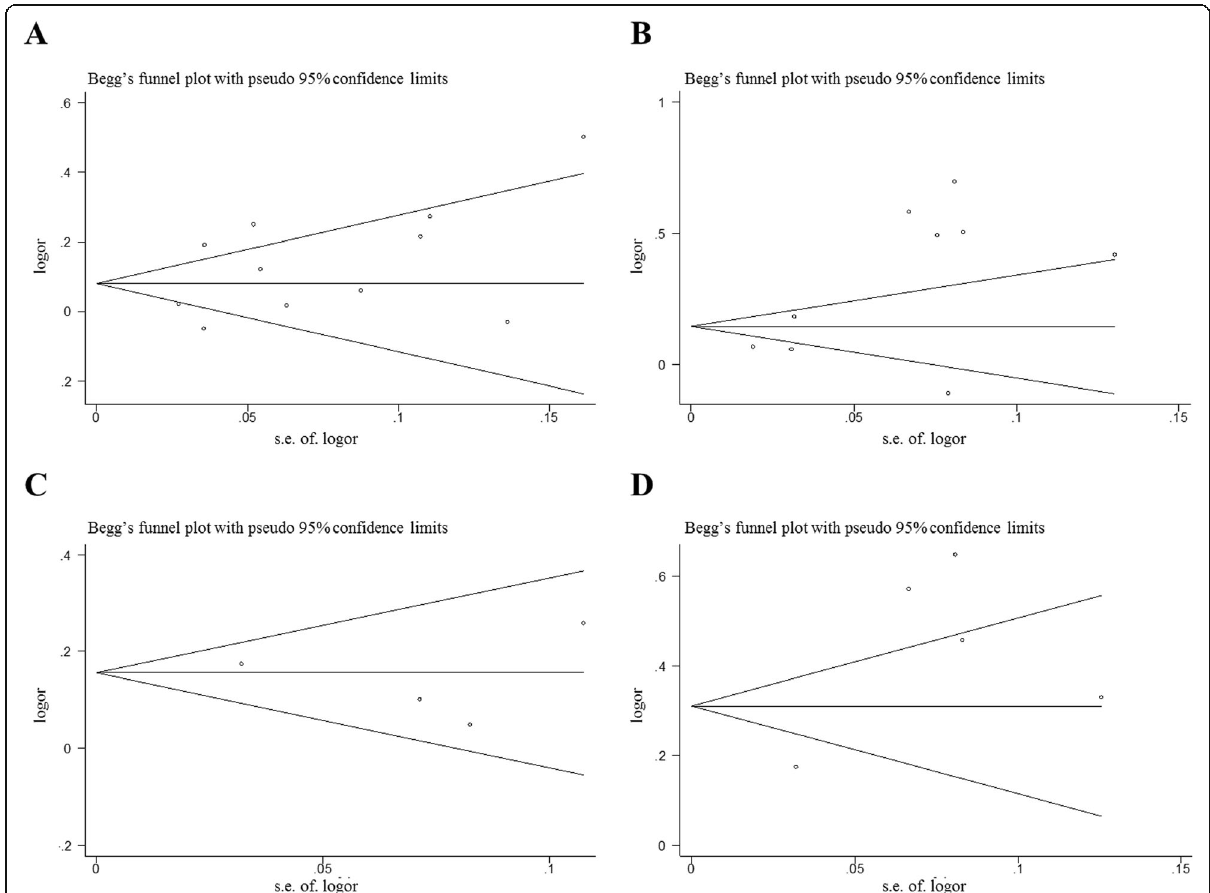
Fig. 4 Begg ’ s funnel plot of publication bias test for rs505922 and rs657152 (allele model and random-effect model); Each point represents a separate study for the indicated association between rs505922 and cancer ( a )/cardiocerebrovascular disease ( b ) risk, and rs657152 and cancer ( c )/ cardiocerebrovascular disease ( d ) risk, respectively. Each point stands for an individual article in overall population under allele model.